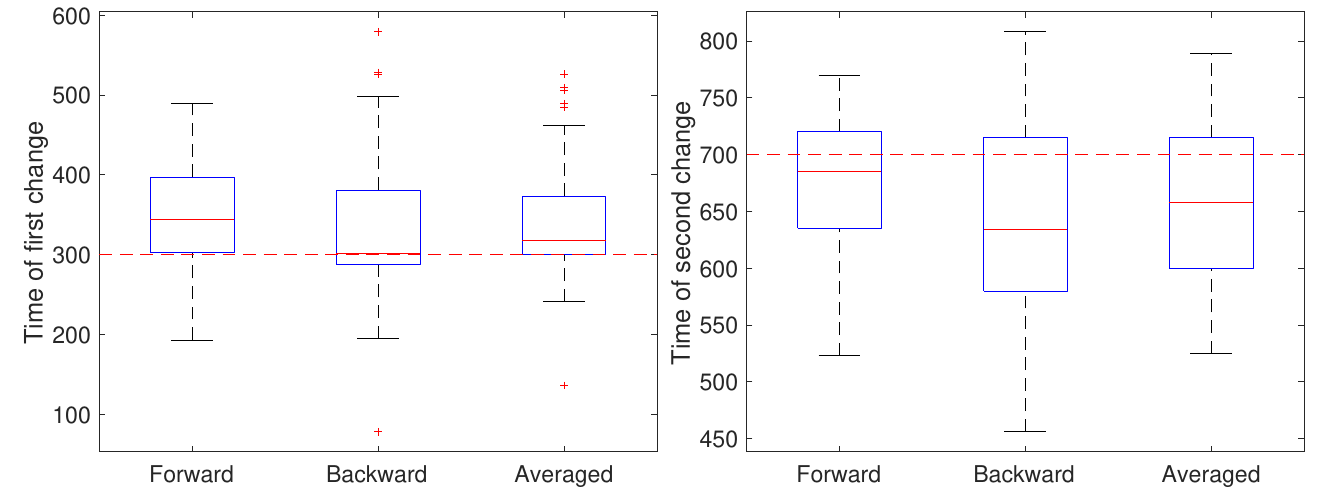
Figure 4. Detected time of change under a low noise setting based on using only the forward pass, only the backward pass, or averaging the two. ( left ) Estimates of the time of the first change (at k = 300) of the parameter a from a value of 1 to 0.8 and ( right ) estimates of the time of the second change (at k = 700 ) back to 1.